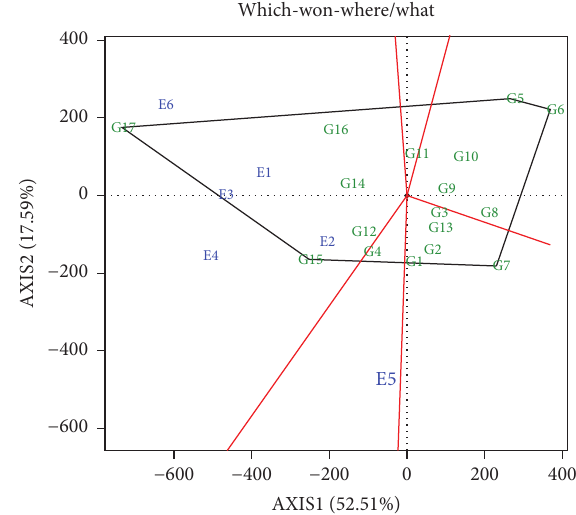
Figure 2: Which-won-where or which is best for what view based on genotype by environment interaction yield data of 17 genotypes evaluated in six environments. Note: E1 � Teppi1, E2 � Gemadro1, E3 � Godare1, E4 � Teppi2, E5 � Gemadro2, E6 � Godare2. G1 � 3/82, G2 � 28/82, G3 � 29/82, G4 � 32/82, G5 � 37/82, G6 � 39/82, G7 � 42/ 82, G8 � 44/82, G9 � 45/82, G10 � 48/82, G11 � 235/71A, G12 � 17/79,